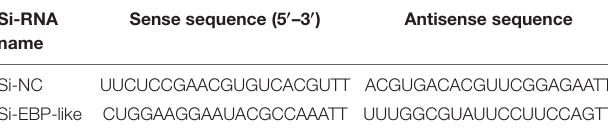
TABLE 3 | Si-RNA sequences. Si-RNA Sense sequence (5 (cid:48) –3 (cid:48) ) name